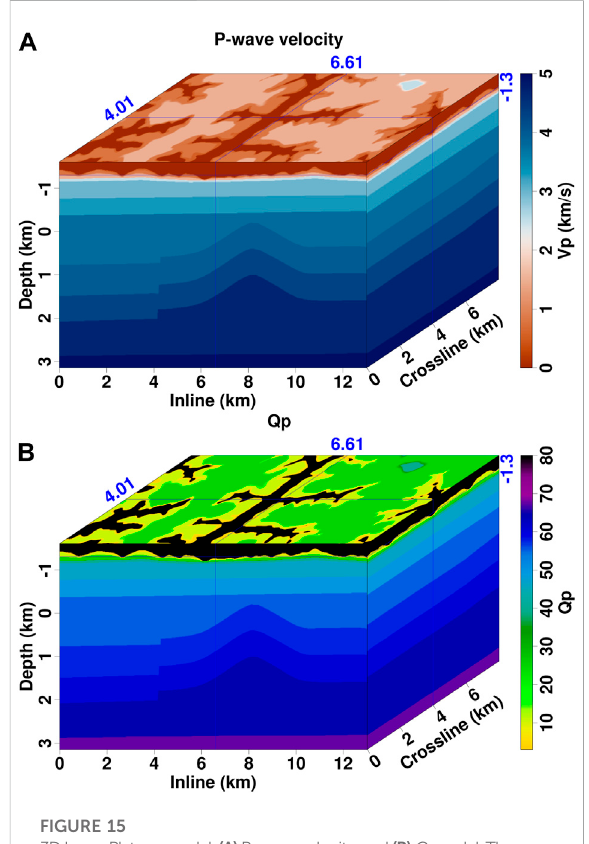
FIGURE 15 3DLoessPlateaumodel. (A) P-wavevelocity,and (B) Q model.The Q value above topography is 1,000 and is clipped to 80 for